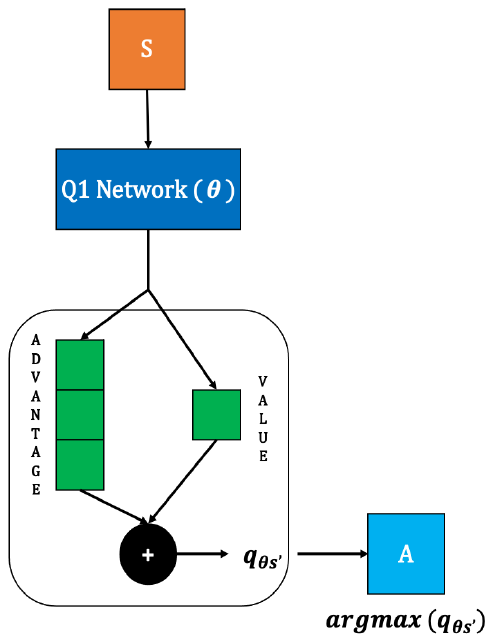
Figure 1. A figure showing the DQN network structure in Grid World. Below shows Dueling DQN.